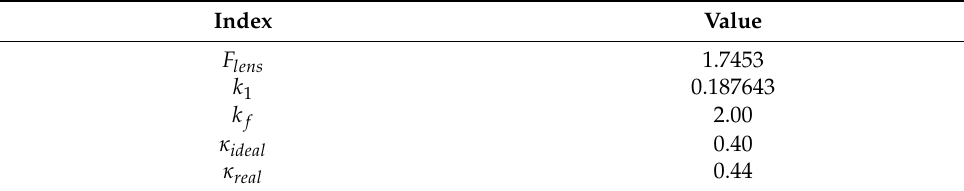
Table 1. The key values of the DST and the ideal ratios value for volume.